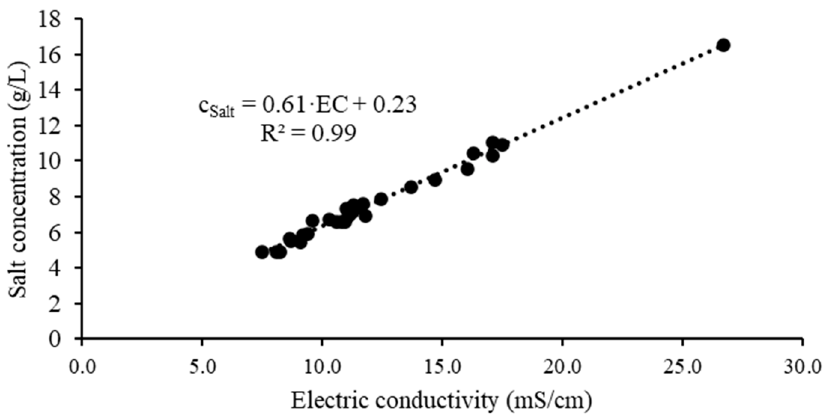
Figure 3. Salt concentration (c Salt ; g/L) as a function of electric conductivity (EC; mS/cm).